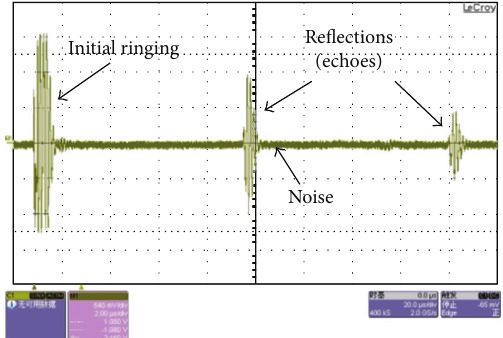
Figure 6: Response of ultrasound in a sample with heat treatment 760 ∘ C and 5 MHz. Scattered waves appear as noise superimposed on the multiple front and back